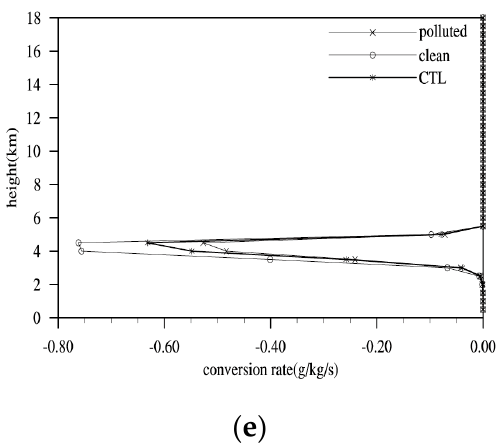
Figure 8. ( a ) Mixing ratio of rain (g kg − 1 ), the conversion rates of ( b ) accretion of cloud water by rain, ( c ) the autoconversion of cloud water into rain, ( d ) the melting of snow, and ( e ) the melting of graupel (10 − 4 g kg − 1 s − 1 ).